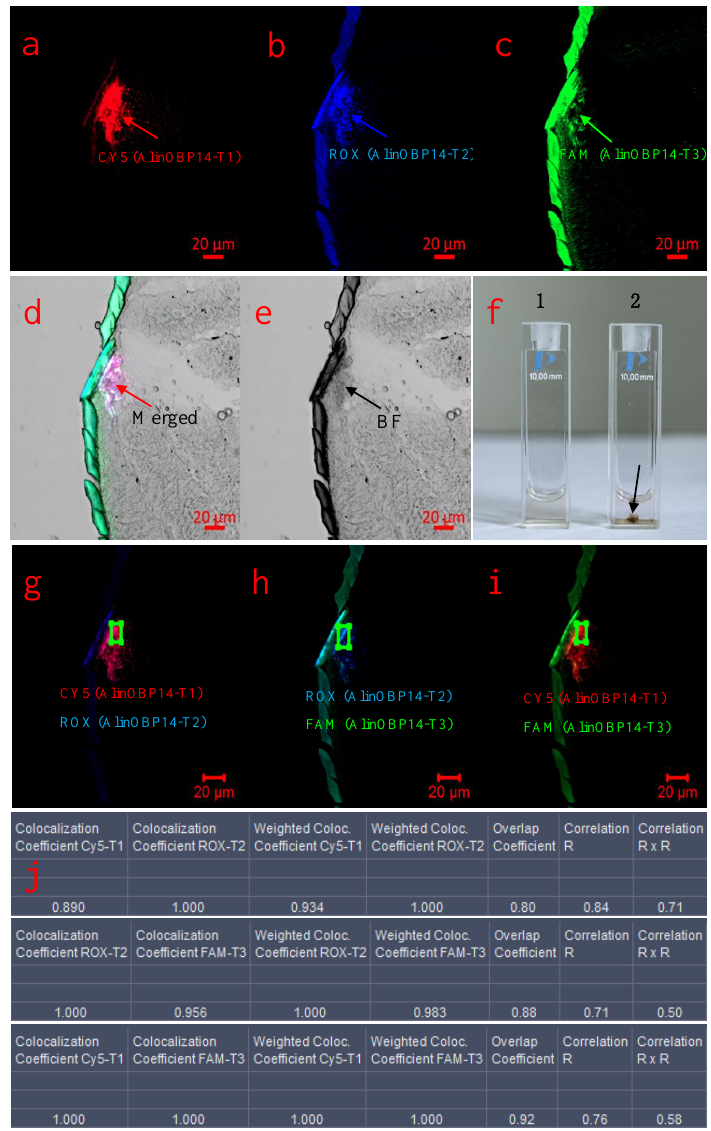
Figure 5. Colocalization analysis of the enhanced fluorescence signals beneath the epidermis of the vertex in the head of adult A. lineolatus. ( a ) Excitation at 643 nm corresponding to CY5-P1 (red arrow). ( b ) Excitation at 575 nm corresponding to ROX-P2 (blue arrow). ( c ) Excitation at 488nm corresponding to FAM-P3 (green arrow). ( d ) Merged image of three different fluorescence channels under a bright-field background showing that the fluorescence signals were intensified beneath the epidermis of the vertex (red arrow). ( e ) A bright-field image of the epidermis of the vertex (black arrow). ( f ) 1 indicates that the solution of PNA-GO-based mRNA biosensor. 2 indicates that the solution of PNA-GO-based mRNA biosensor was mixed with chemically synthesized targets (AlinOBP-T1, AlinOBP-T2, and AlinOBP-T3) in vitro. The black arrow points to the aggregation of GO sheets in vitro. After background correction, images were processed for colocalization analysis. ( g ) The spatial overlap of CY5-P1 and ROX-P2 fluorescence channels in a multichannel image. The green box indicates the area with colocalization of CY5-P1 with ROX-P2. ( h ) The spatial overlap of ROX-P2 and FAM-P3 fluorescence channels in a multichannel image. The green box indicates the area with colocalization of ROX-P2 with FAM-P3. ( i ) The spatial overlap of CY5-P1 and FAM-P3 fluorescence channels in a multichannel image. The green box indicates the area with colocalization of CY5-P1 with FAM-P3. ( j ) The values of coefficients calculated using images for CY5-P1 and ROX-P2, ROX-P2 and FAM-P3, and CY5-P1 and FAM-P3, respectively. The scale bar indicates 20 µ m ( a – e , g – i